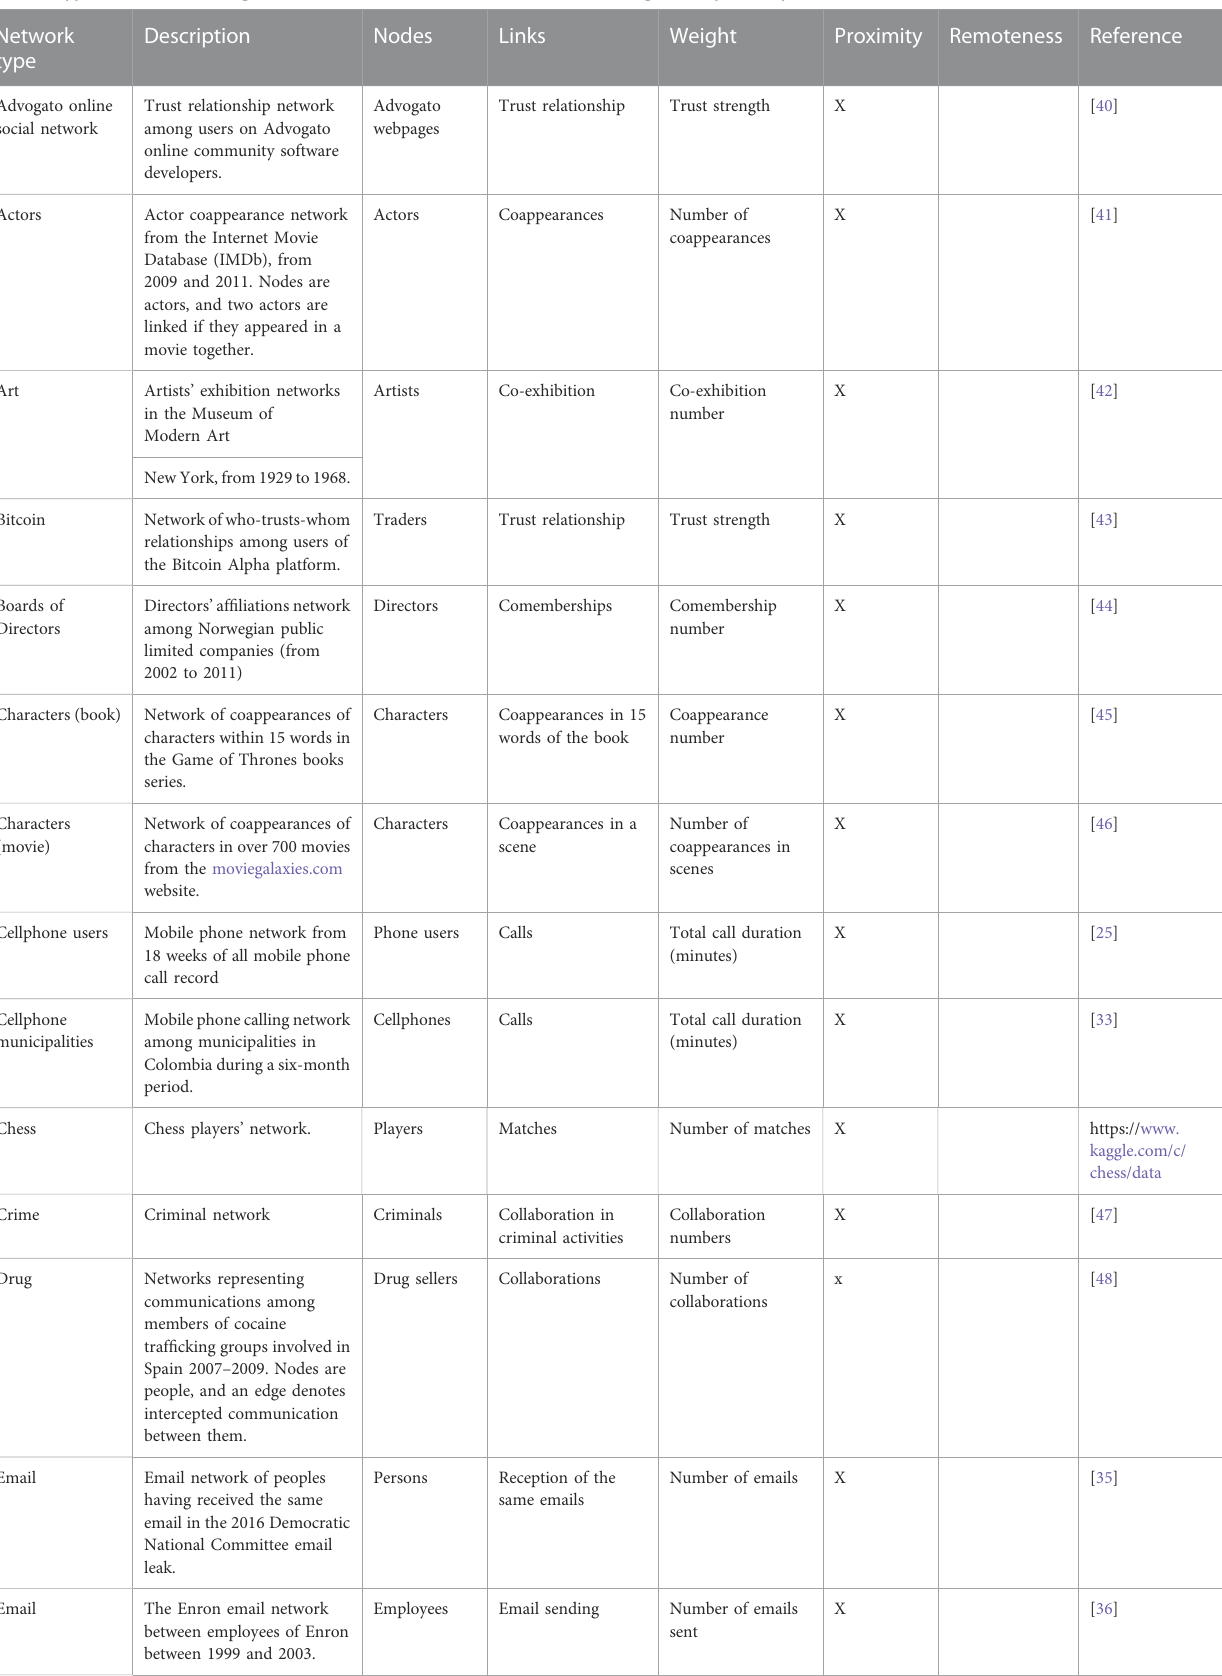
TABLE 1 Types of real-world weighted social networks. The “ x ” indicates if link weights are proximity or remoteness. Network